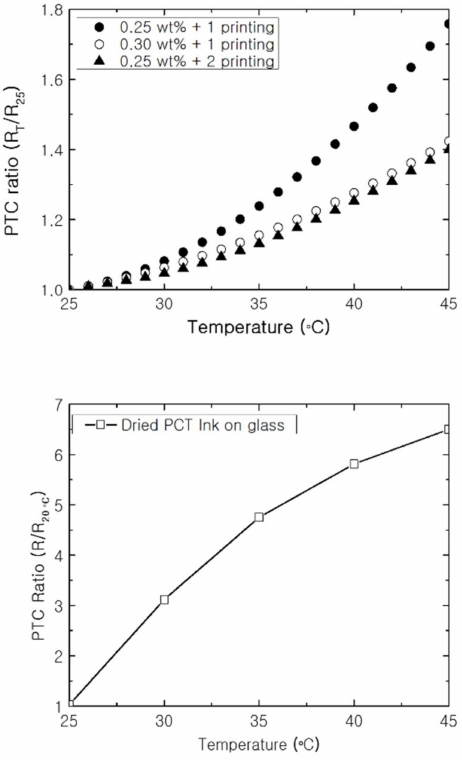
Figure 7. PTC ratio according to temperature increase of the PTC-SHT ( top ) and PTC ink on a glass substrate ( bottom